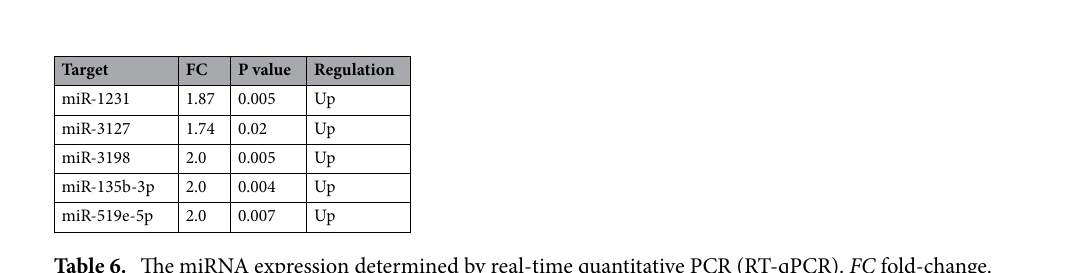
Table 6. The miRNA expression determined by real-time quantitative PCR (RT-qPCR). FC fold-change.